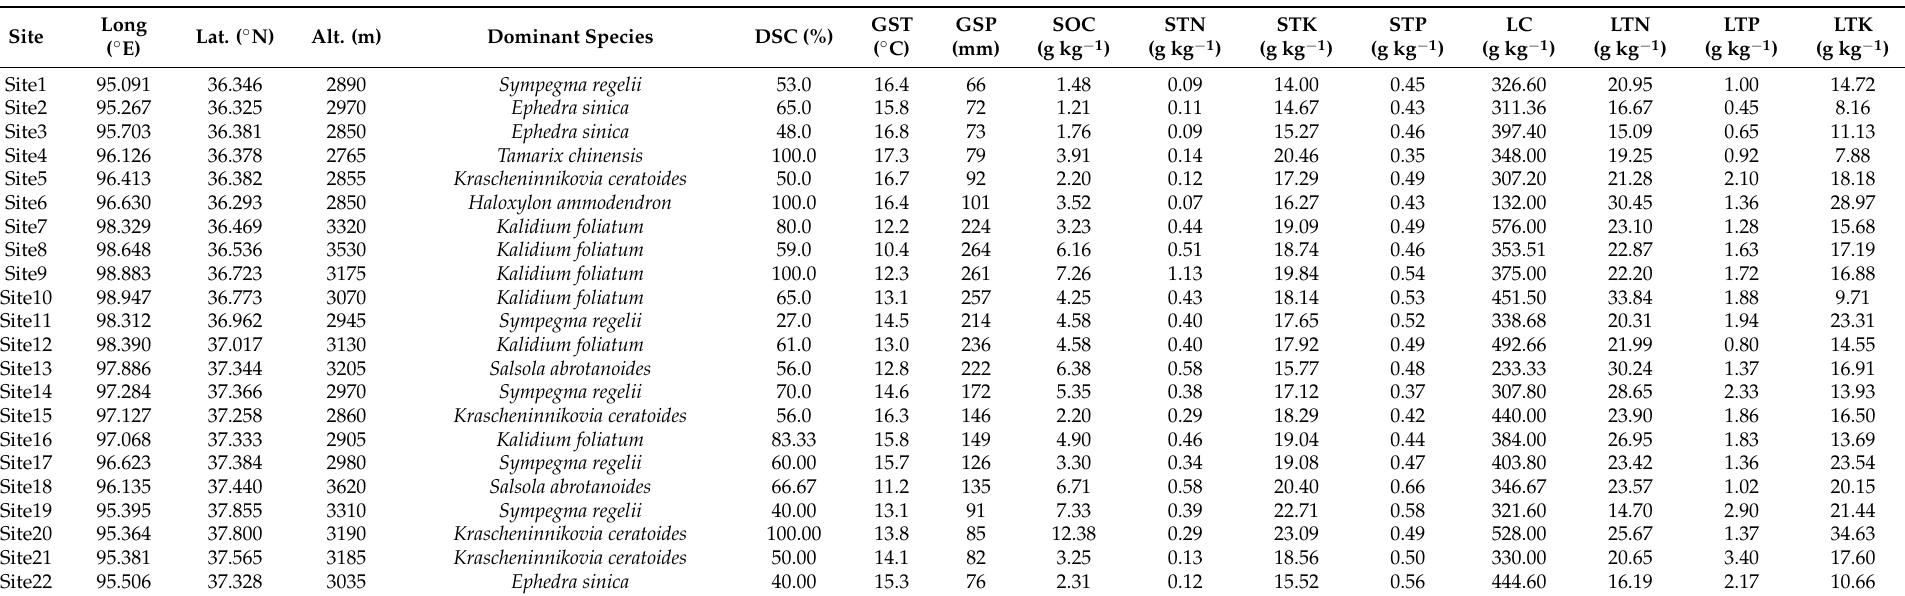
Table 1. Locations, the most dominant species and their relative coverage (DSC), climate conditions, soil properties, and plant nutrient traits at each site sampled in 2016 across the Qaidam Basin. GST and GSP refer to the average temperature and precipitation during the plant growing season. Soil properties included the contents of organic carbon (SOC), total nitrogen (STN), total phosphorus (STP), and total potassium (STK) of topsoils at the 0–50 cm depth. Plant nutrient traits were the community weighted means (CWMs) of leaf carbon (LC), total nitrogen (LTN), total phosphorus (LTP), and total potassium (LTK) in the leaves of all plants at each sampling